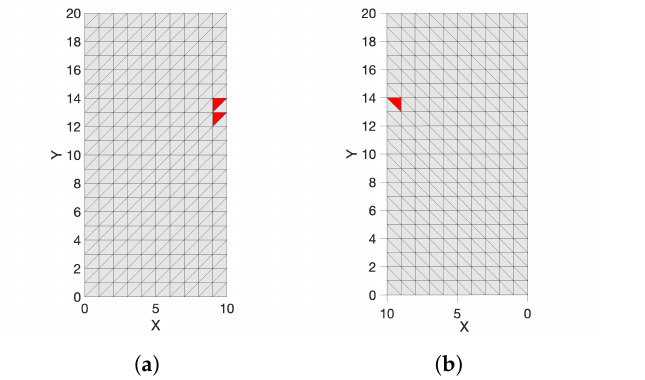
Figure 3. Identified elements affected by the damage (in red) at the first iteration ( q = 1) of the algorithm proposed in Section 3.1. ( a ) Top view; ( b ) bottom view.